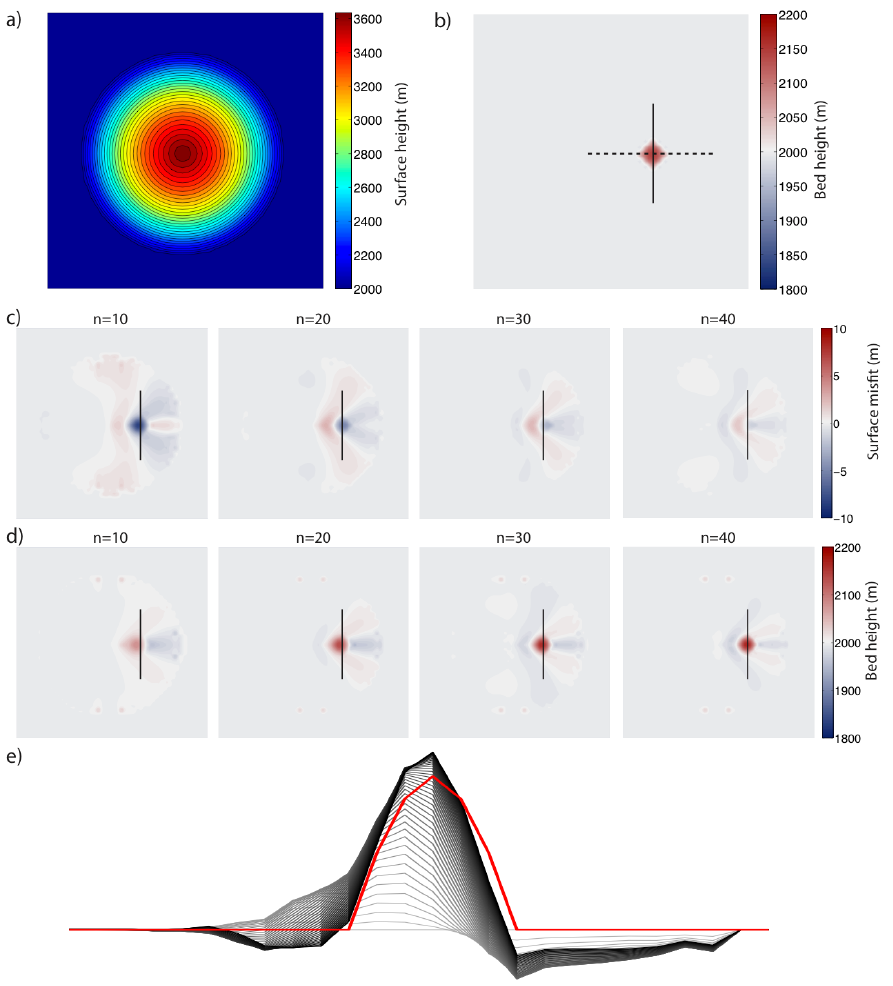
Fig. 2. Recovery of a single bump with an amplitude of 150m in an otherwise flat bed. Panels (a) and (b) show reference surface and bed heights; (c) and (d) show snapshots of the surface height misfit and recovered bed height after n = 10, 20, 30 and 40 iterations. In (e) the gradual recovery of the bed is illustrated along the cross-section marked by the dashed line in (b) ; every line represents the bed after a certain iteration while the grayscale is a measure for the iteration number (low is light gray, high is black); the red line marks the reference bed height. Solid lines in (b) , (c) and (d) mark a fixed position to illustrate movement of the recovered bump and surface